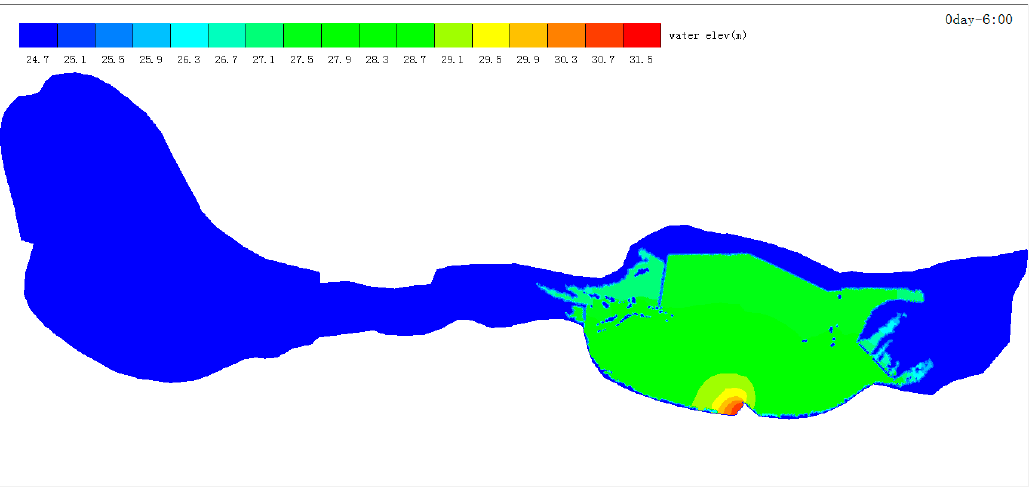
Figure 7. 2-D hydraulic model calculation result.